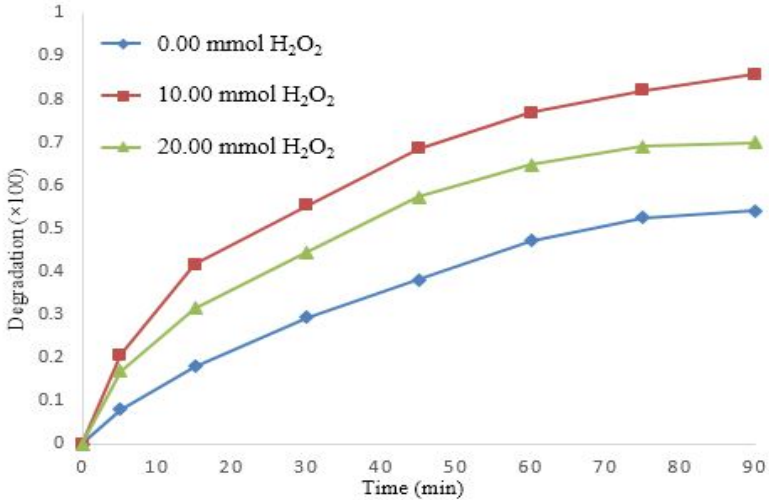
Fig. 13. Effect of H